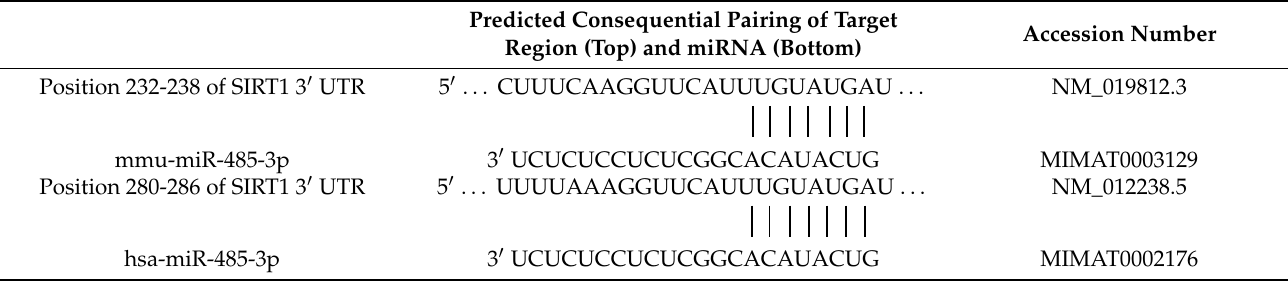
Table 3. The predicted binding region between SIRT1 and miR-485-3p. Predicted Consequential Pairing of Target Re- gion (Top) and miRNA